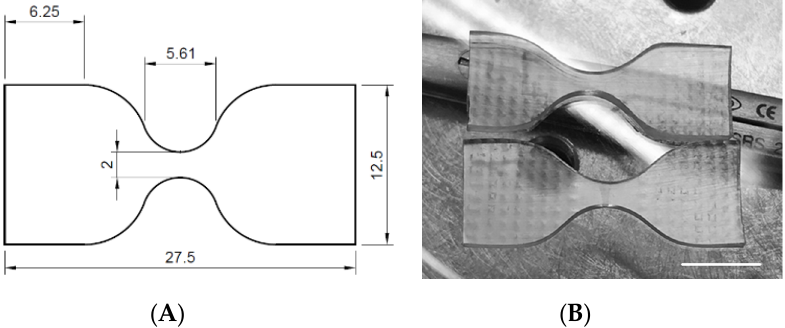
Figure 4. Dog-bone-shaped samples: ( A ) dimensions and ( B ) aspects of the tested specimens (scale bar = 10 mm).